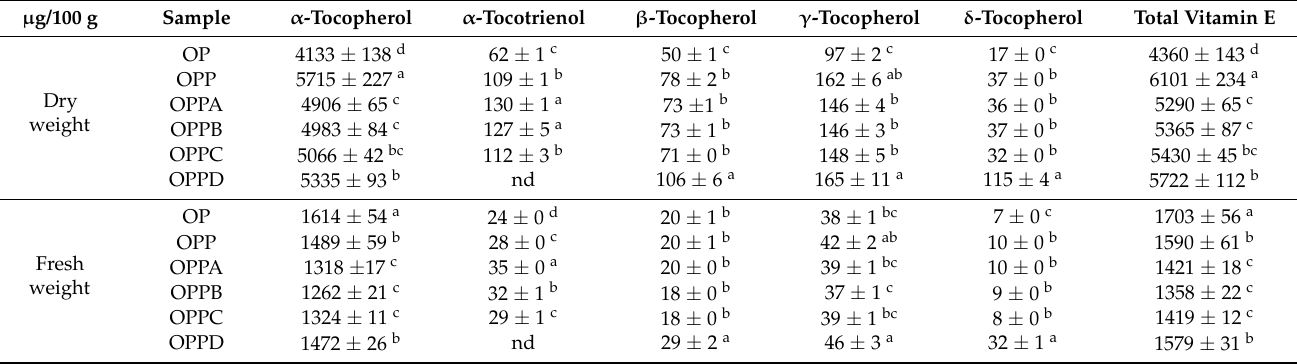
Table 2. Vitamin E profile of olive pomace samples.